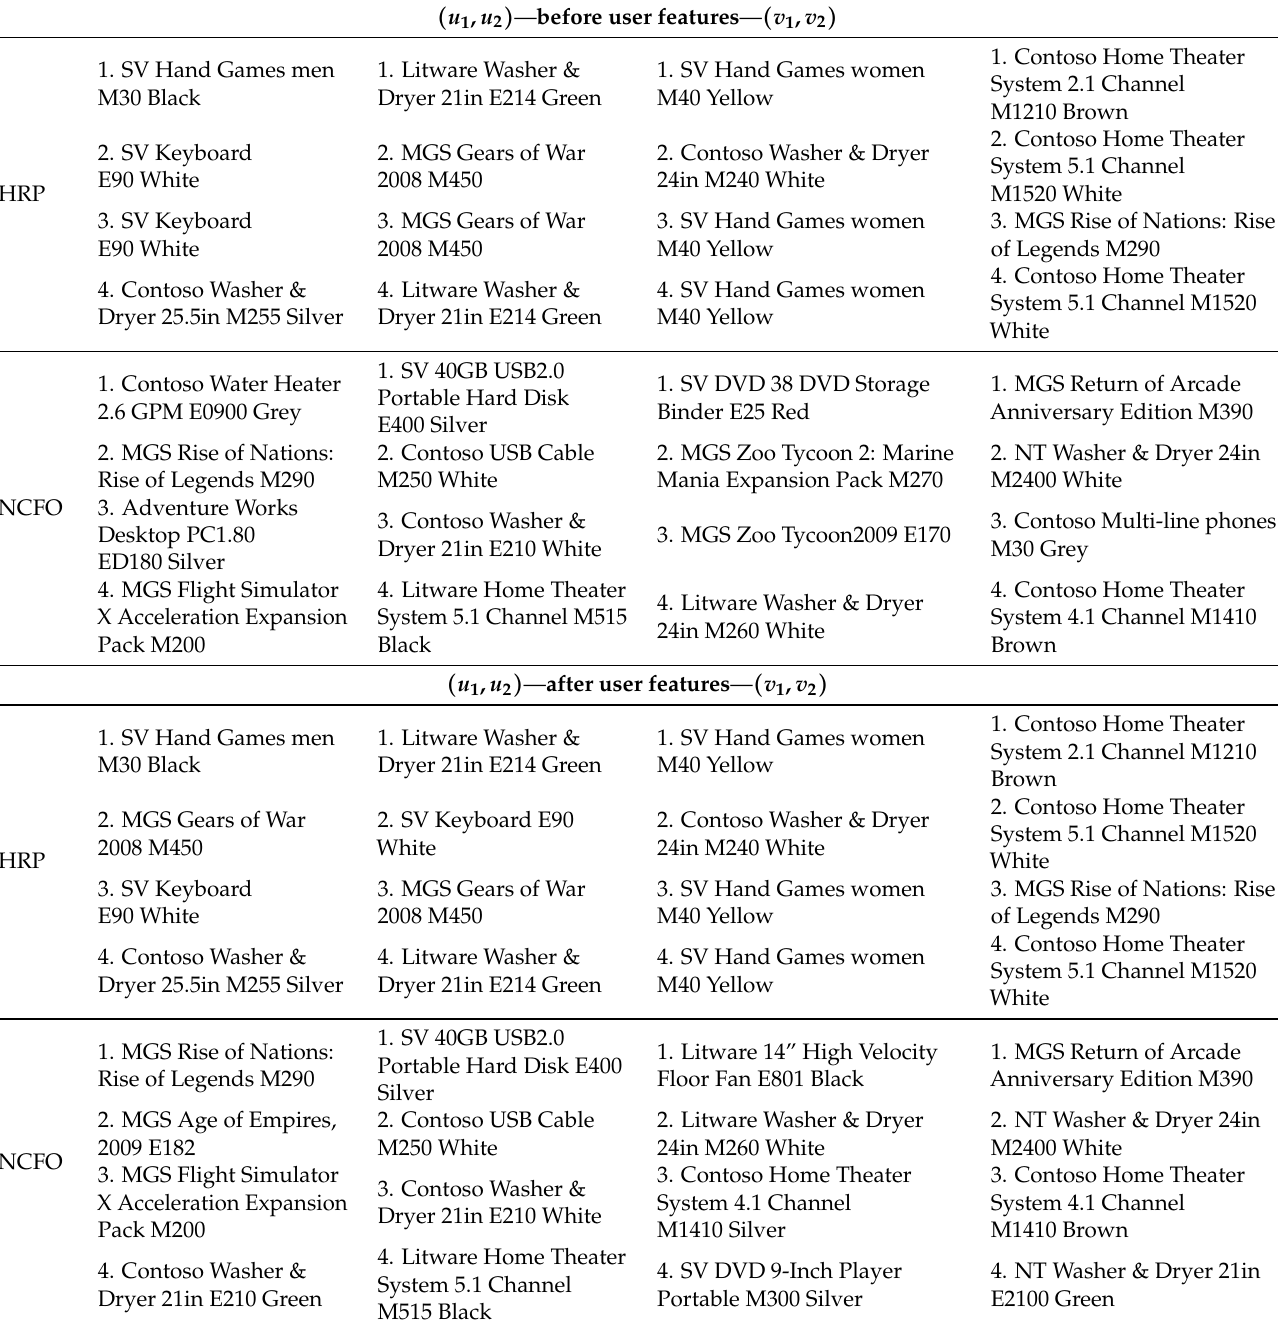
Table 10. Top-four recommendations (NCFO) and highly rated products for two pairs of aligned users. Evolved dataset and